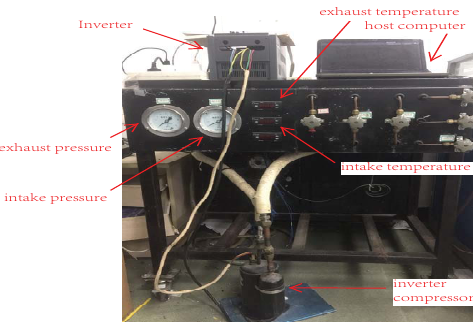
Figure 19. Experimental platform of an inverter compressor driving system.